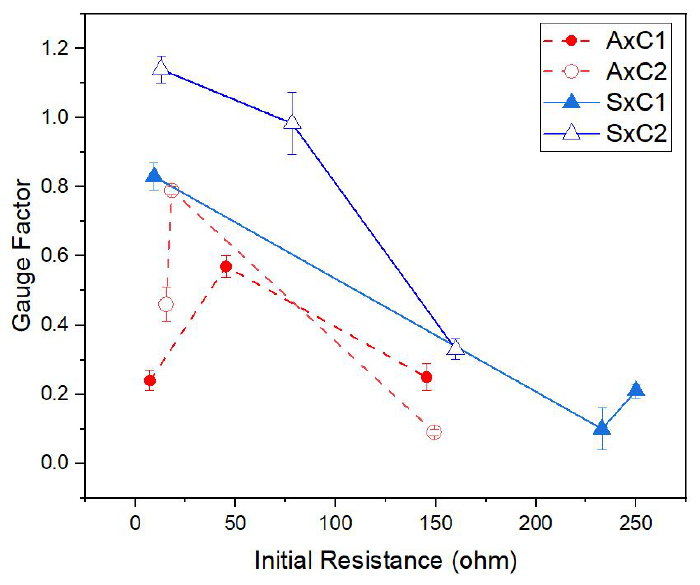
Figure 12. Gauge factor versus initial sensor resistance plots of sensors knitted with conductive yarn inside (CI) and NP 9 ; Sensors knitted with Shieldex yarns (S 1 , S 2 and S 3 ) are indicated with blue straight lines, and Amann yarns (A 1 , A 2 and A 3 ) with red dashed